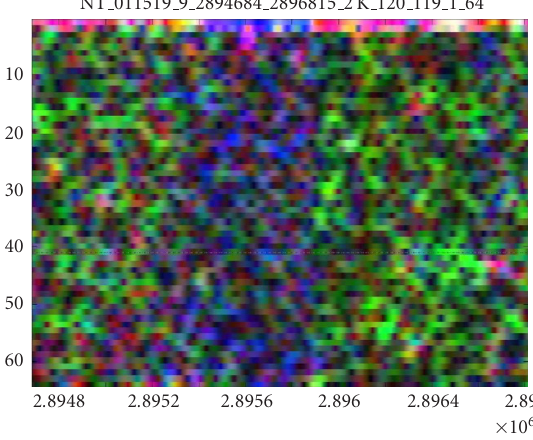
Figure 13: Spectrogram showing two CpG islands separated by a sequence very rich in the nucleotide A . Both islands yielded blast results showing T-box